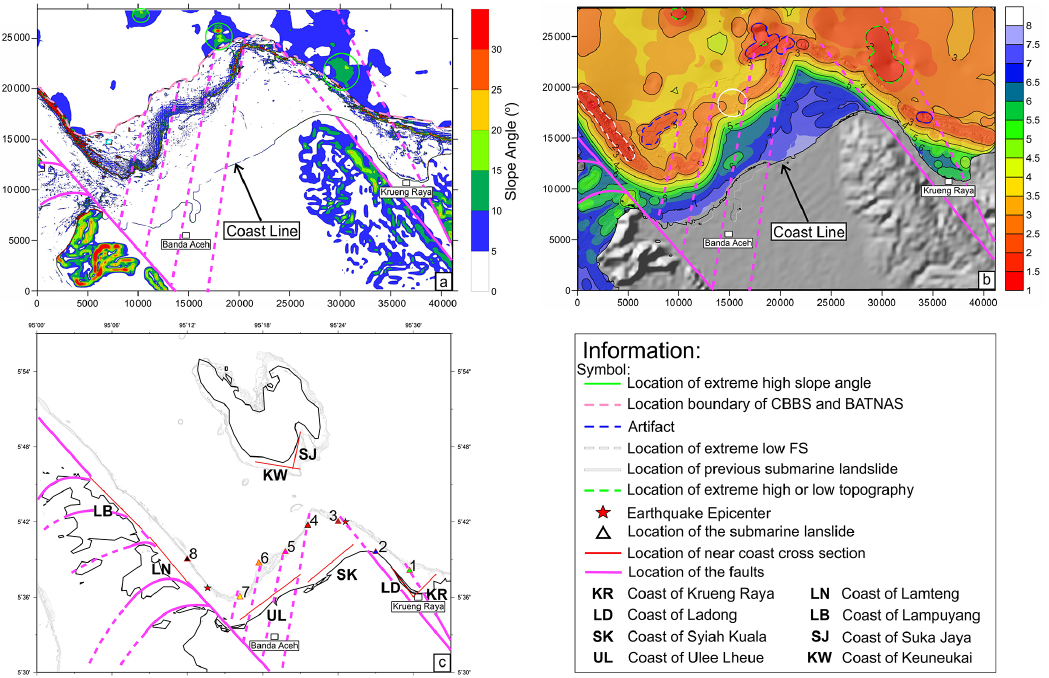
Figure 6. Regional slope distribution, slope stability analysis, location of the submarine landslide sources for the tsunami simulation scenarios and the location of near-coast cross sections. (a) Map of slope angles. (b) FS from the slope stability analysis; red indicates higher likelihood of failure. (c) Submarine landslide locations and their corresponding numbers; tsunami simulation scenarios are in Table